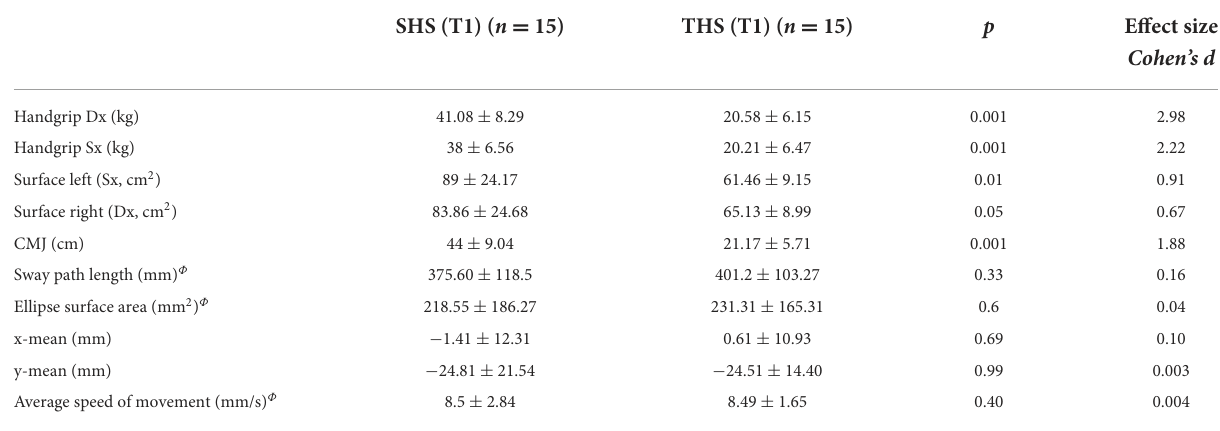
TABLE 3 Unpaired t-test analysis between SHS (T1) vs. THS